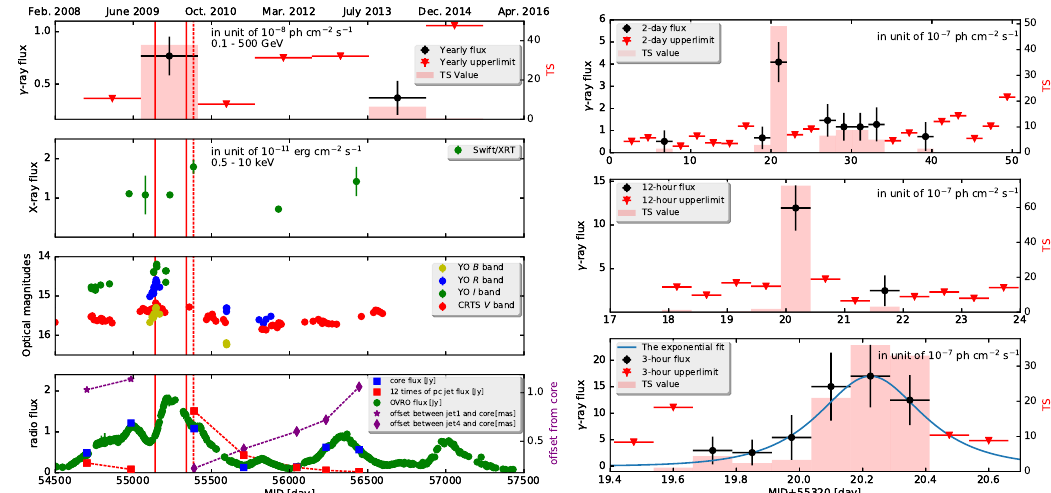
Figure 2. ( Left ) The multiwavelength light curves of III Zw 2. In the γ -ray ( Fermi -LAT) panel, the black circles correspond to the fluxes and the red triangles are the 2 σ upper limits. The red bars are the TS values in each data bin. In the optical panel, green, blue, and yellow circles are the magnitudes of I , R , and B bands observed in Yunnan Observatories, respectively. The red circles are CRTS V band magnitudes minus 0.8 mag (for more details see Section 2.3 in Liao et al. (2016) [29]). In the radio panel, the green circles are OVRO single-dish flux densities, and the blue and purple circles are the MOJAVE core and parsec jet VLBA flux densities. The two solid red vertical lines mark the peaking times of the two γ -ray flares and the dashed red vertical line corresponds to the time of the simultaneous Planck , Swift , and Fermi campaign. ( Right ) Zoomed-in Fermi -LAT γ -ray light curves for the γ -ray flare on May 2010, including the 2-day bin (upper panel), 12-h bin (middle panel), and 3-h (bottom panel) light curves. A exponential fit of this intense flare is also shown along with the 3-h light curve. This figure can be also seen in Liao et al. (2016)